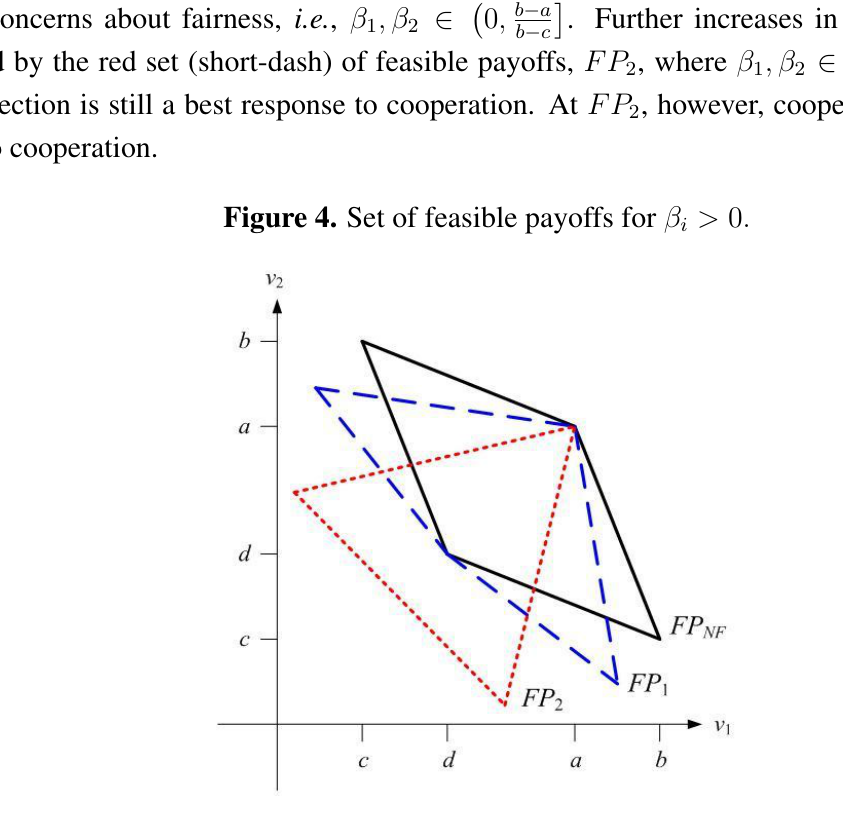
Figure 4. Set of feasible payoffs for β